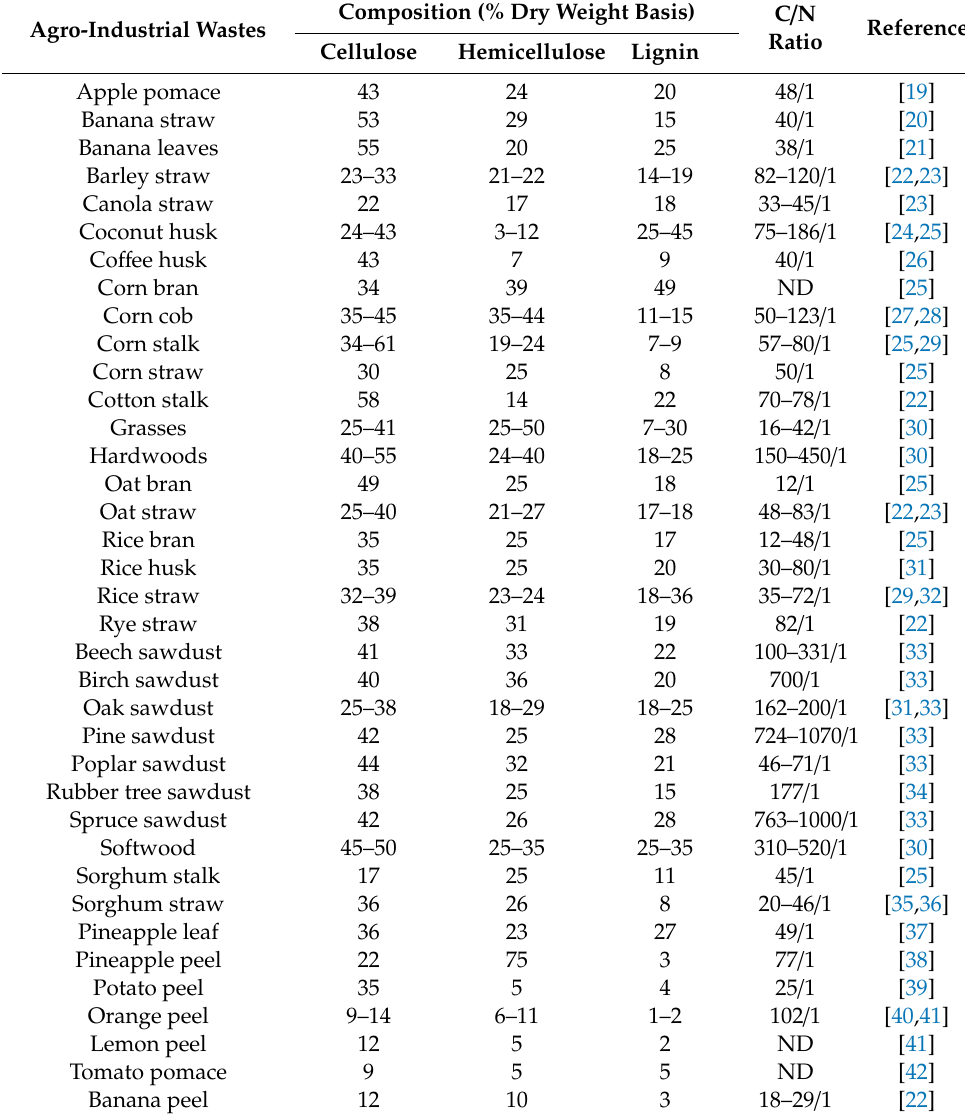
Table 1. Main composition and carbon / nitrogen (C / N) ratio of some agro-industrial wastes. Agro-Industrial